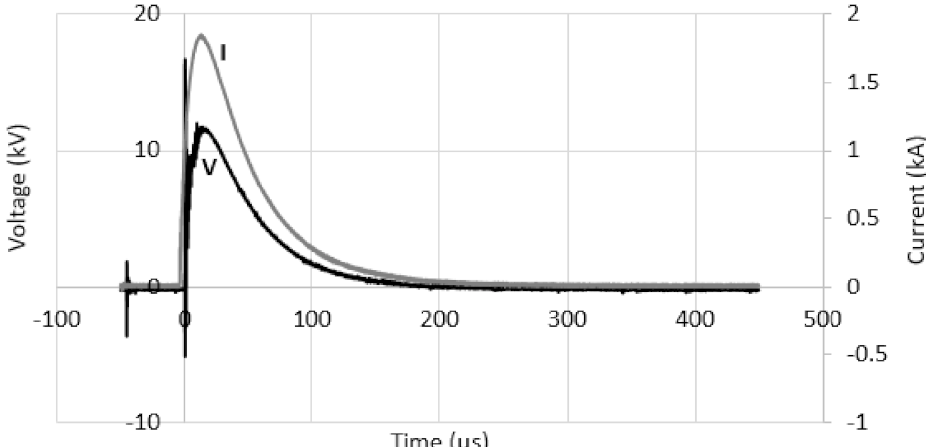
Figure 2. Voltage and current traces, measured with voltage divider 1 and current transformer 1, respectively, for configuration (f) installed at site